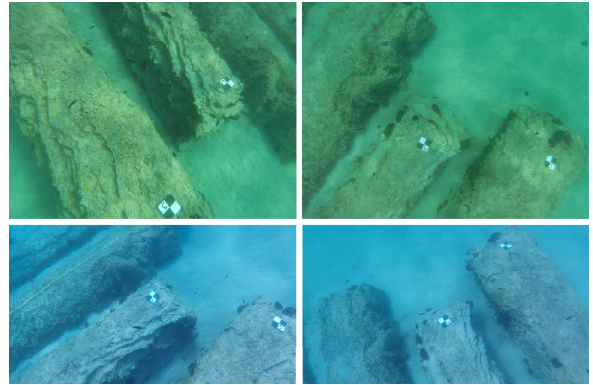
Figure 9. Statistical analysis with Gauss Curve and Histogram on the Photogrammetric point cloud of GoPro - Nikon.